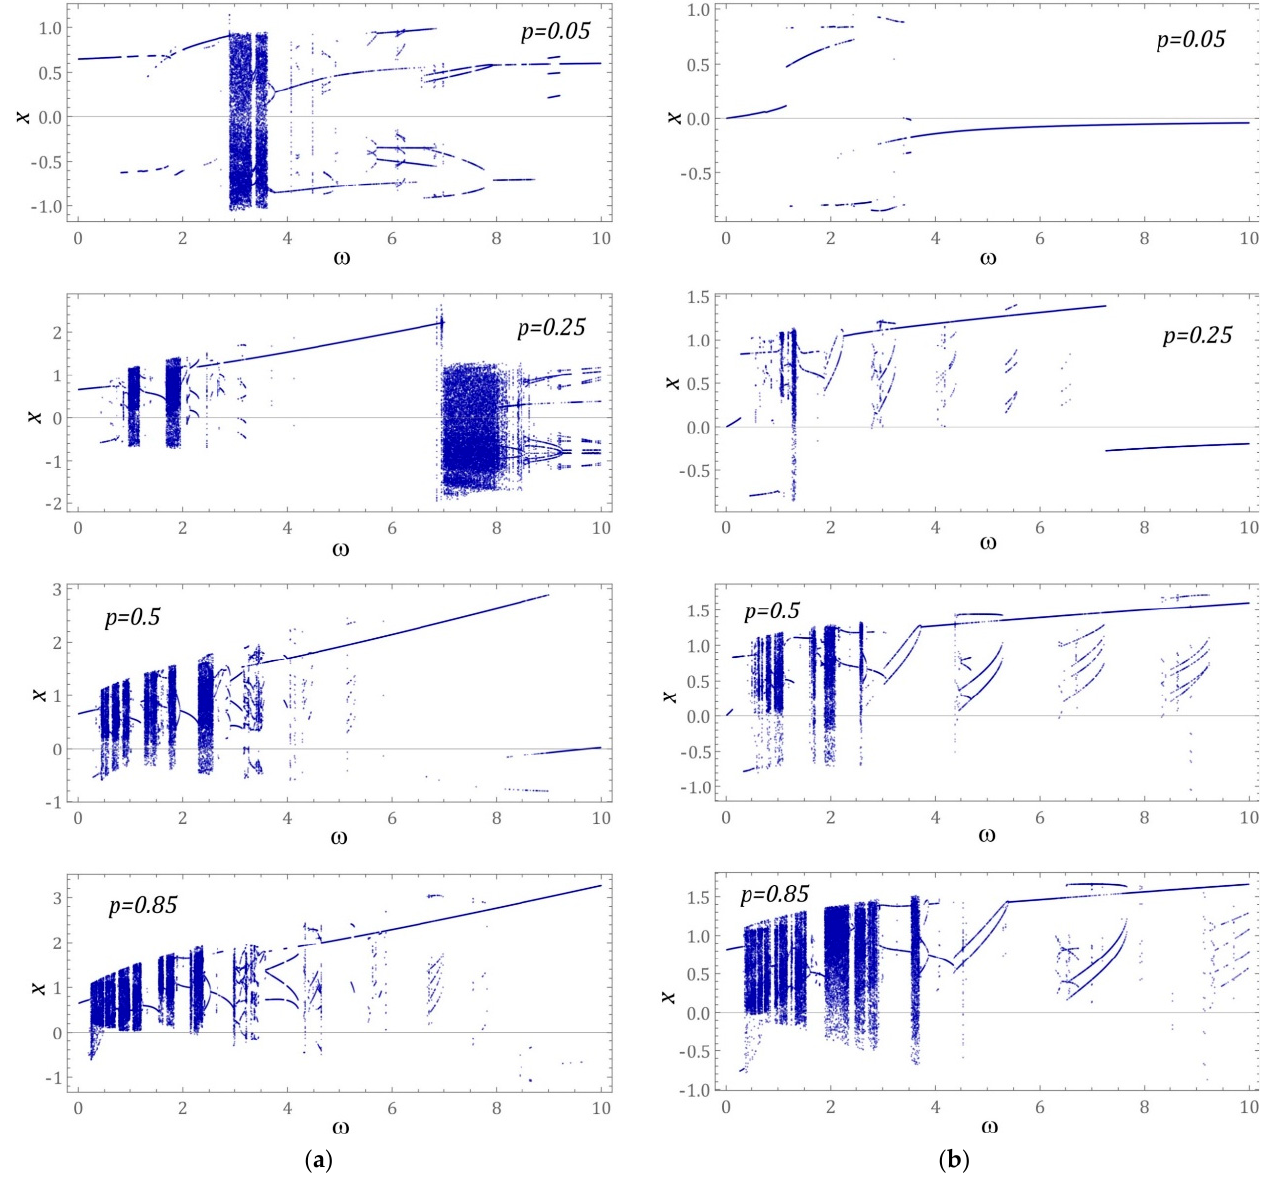
Figure 6. Bifurcation diagrams (stroboscopic) of steady states of the system against frequency for: ( a ) two potential wells and ( b ) three potential wells. The excitation amplitude increases downwards from 0.05 to 0.85 and its values are listed in the corresponding subfigures. The results were obtained for zero initial conditions. ω and x are